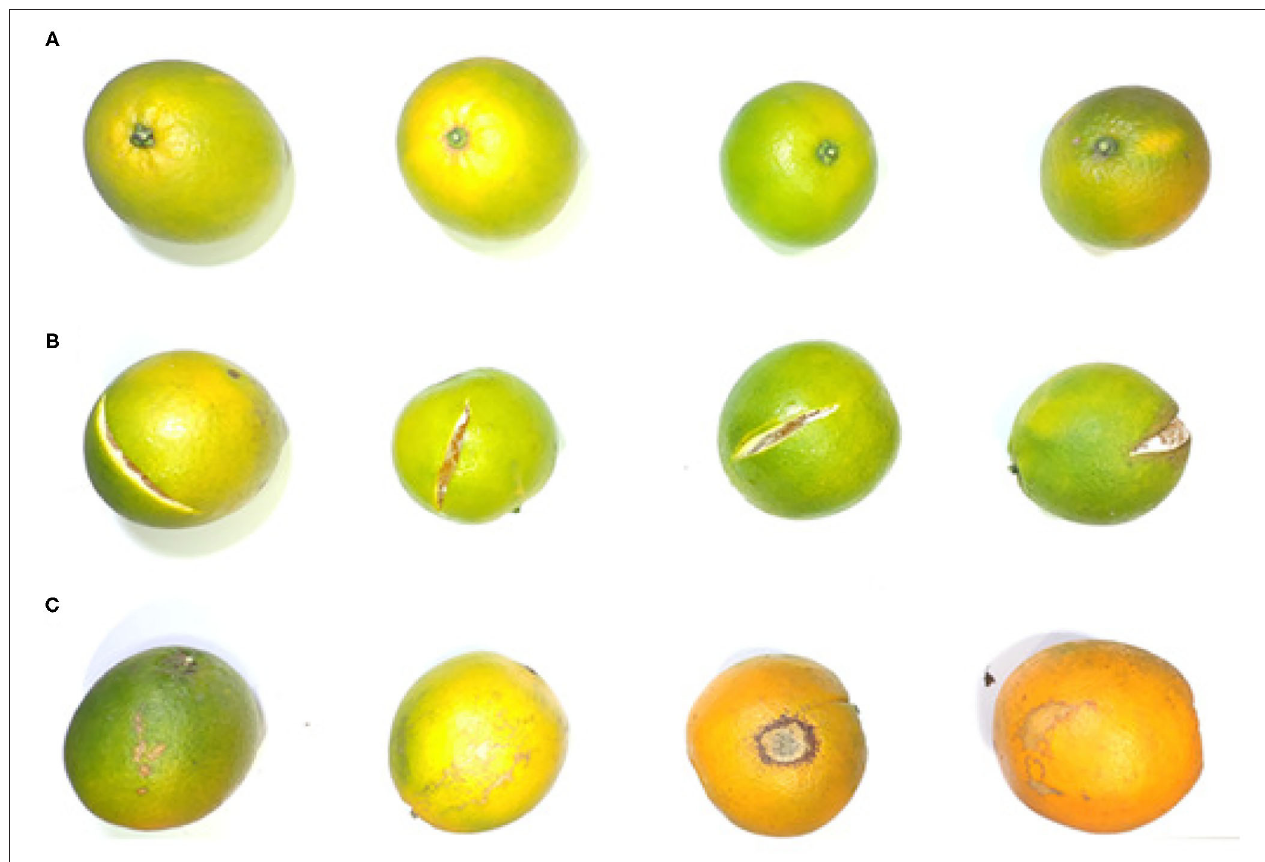
FIGURE 1 | Sample oranges are classified into three categories, including (A) normal, (B) mechanical damaged (MD), and (C) with skin lesions